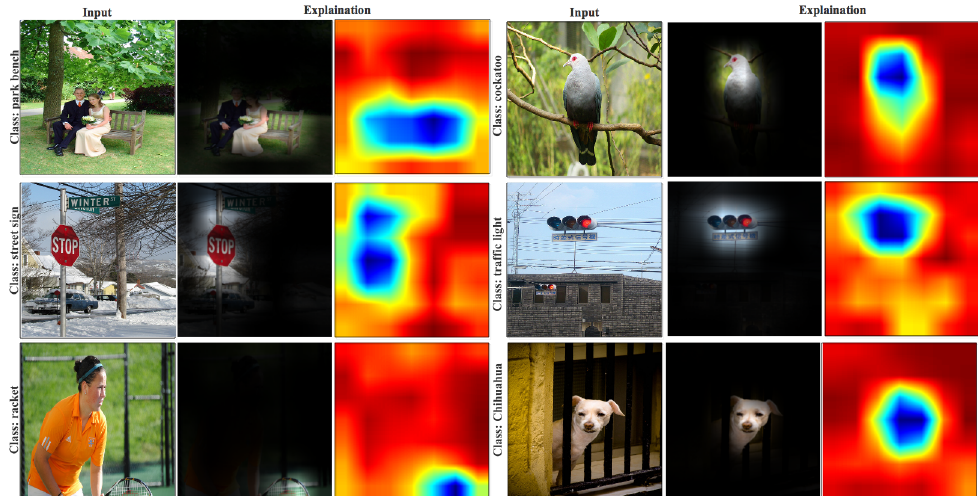
Figure 12. Deep visual explanation [90] highlights the most discriminative region in an image of six examples (park bench, cockatoo, street sign, traffic light, racket, chihuahua) to explain the decision made by